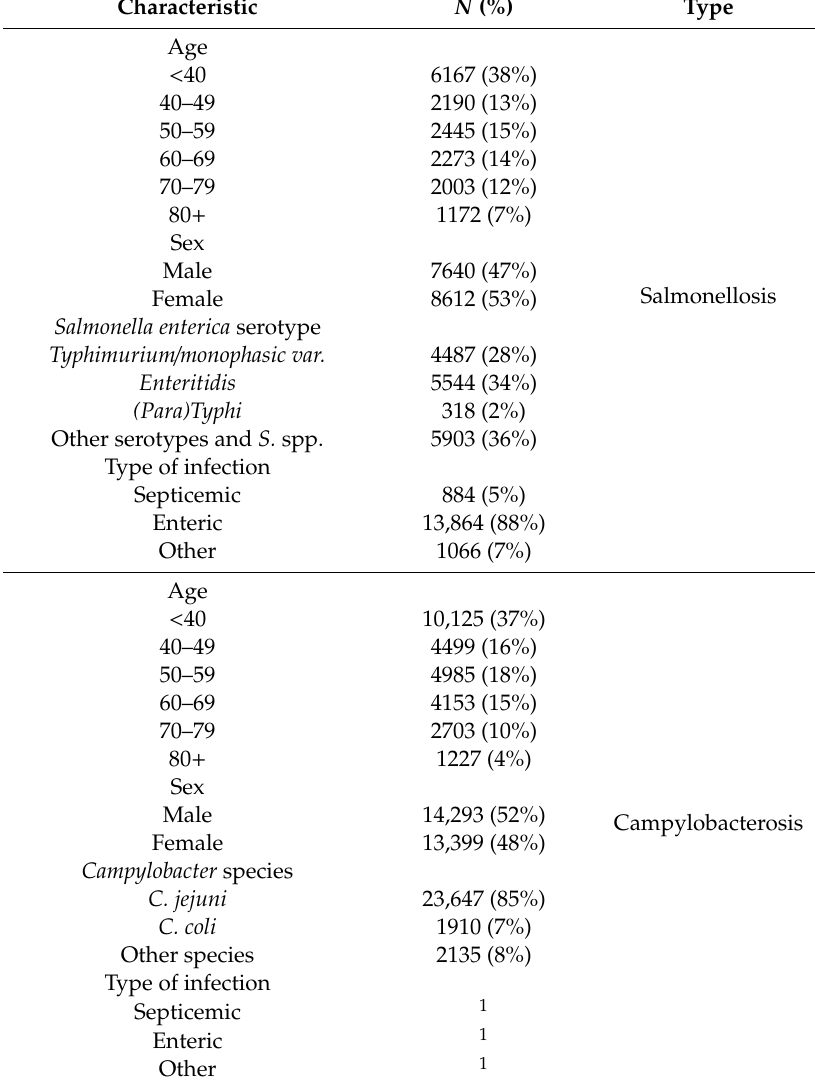
Table 1. Baseline characteristics of the Salmonellosis and Campylobacterosis patients.